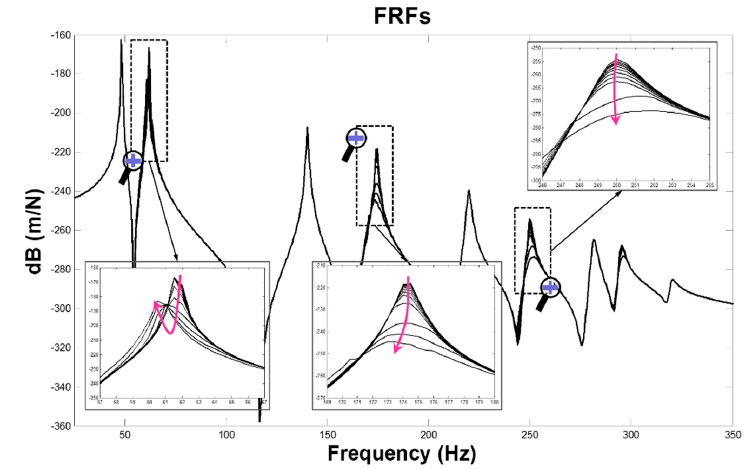
Figure 4. Numerically obtained twelve number of frequency response functions with respect to step sine excitations.